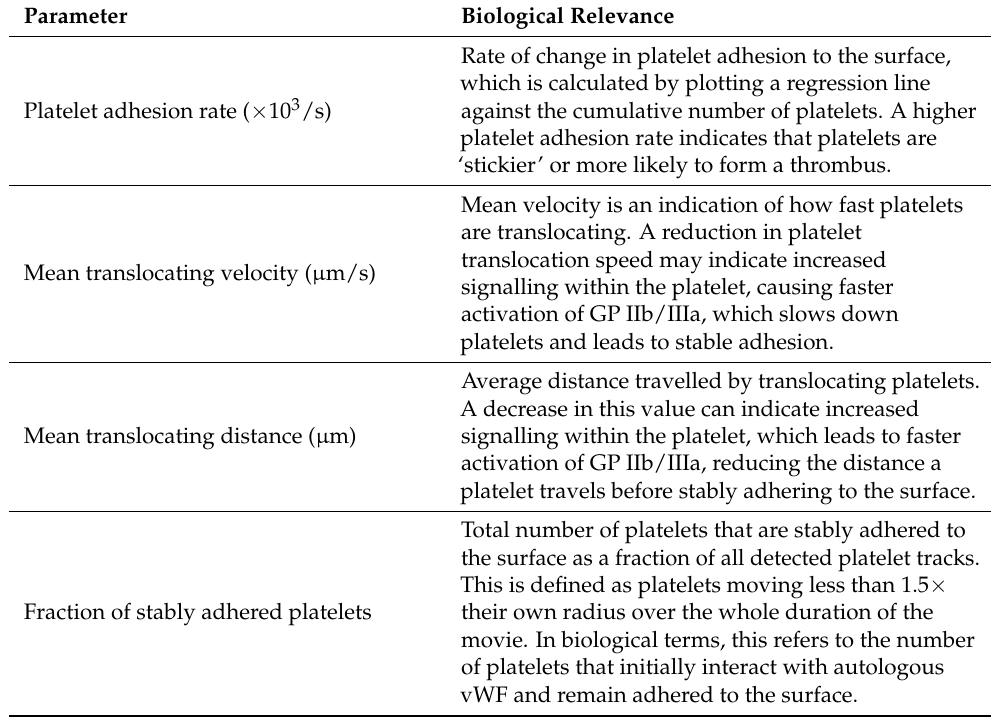
Table 2. Description of platelet parameters measured and their biological